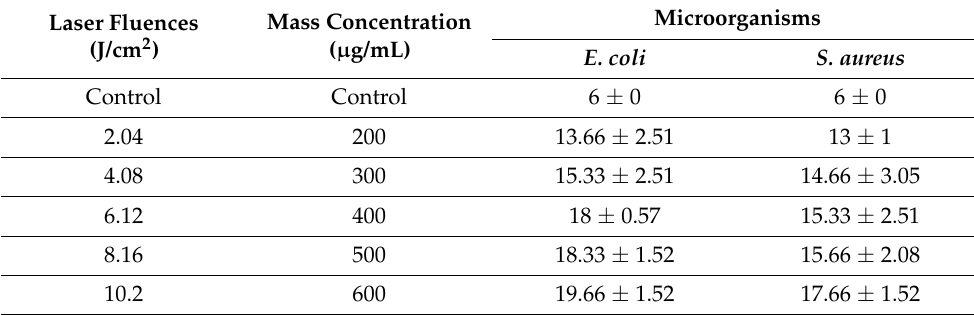
Table 2. The antibacterial activity of palladium nanoparticles (Pd NPs) prepared by pulsed laser ablation of palladium target in DI water with different laser fluences against E. coli and Staphylococcus aureus bacterial